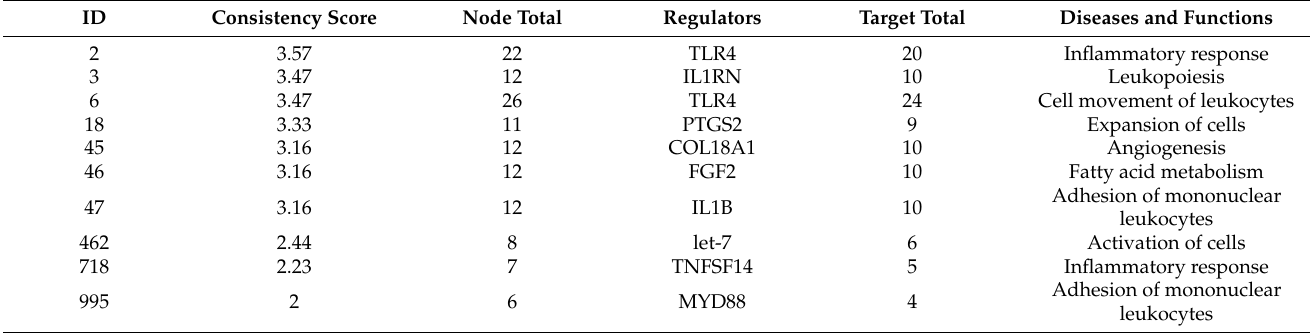
Table 6. Regulators effect: list of predicted networks by IPA for w/ TNF α